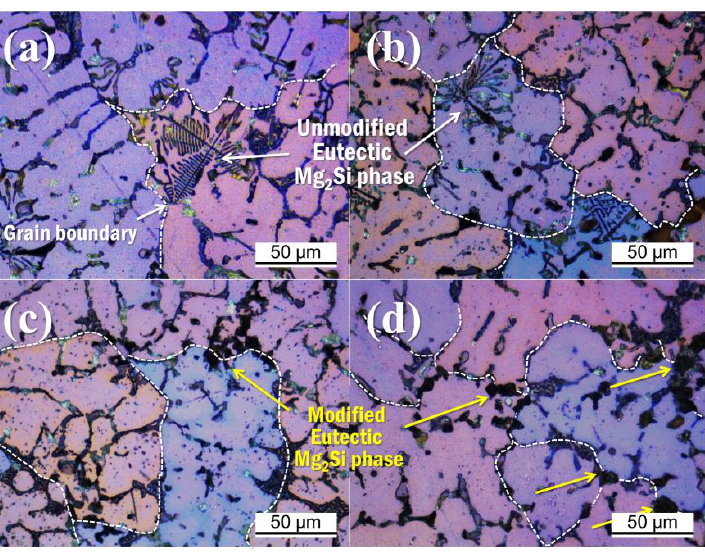
Figure 4. Polarized microscope images (high magnification) of the Al–8Zn–6Si–4Mg–2Cu alloys with different amounts of Ti: ( a ) without Ti; ( b ) at 0.1% of Ti; ( c ) at 0.5% of Ti; and ( d ) at 1% of Ti. Here, the white dotted line represents the grain boundaries. The white and yellow arrows represent unmodified and modified eutectic Al + Mg 2 Si phases, respectively.